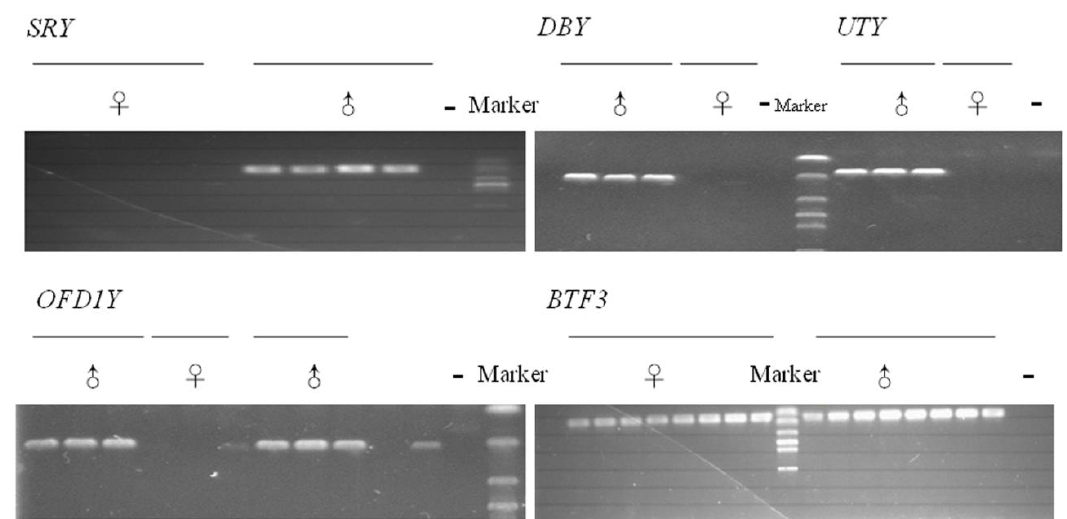
Figure 1. Gel electrophoresis of PCR products of the bu ff alo sex determining Region of Y-Chromosome ( SRY ), ubiquitously transcribed tetratricopeptide repeat gene protein on the chromosome Y ( UTY ), DEAD -box helicase 3 Y-linked (DDX3Y, also known as DBY ), and oral-facial-digital syndrome 1 Y-linked ( OFD1Y ) genes. The primers of the SRY, DBY, UTY, and OFD1Y genes amplified male-specific band. Marker, D2000 DNA ladder; the “ ” represents the male bu ff alo genomic DNA; the “ ” represents the female ♀ ♂ bu ff alo genomic DNA; the “-” represents the blank control (distilled water). Table 1. The median copy number of SRY , DBY , UTY , and OFD1Y genes in 16 bu ff alo populations.